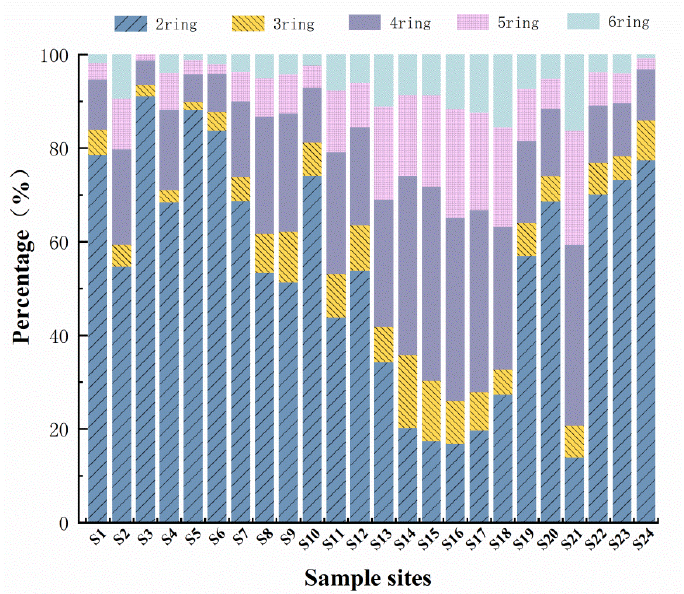
Figure 3. Composition of PAHs in the surface sediment collection from the lake bay and adjoining river.